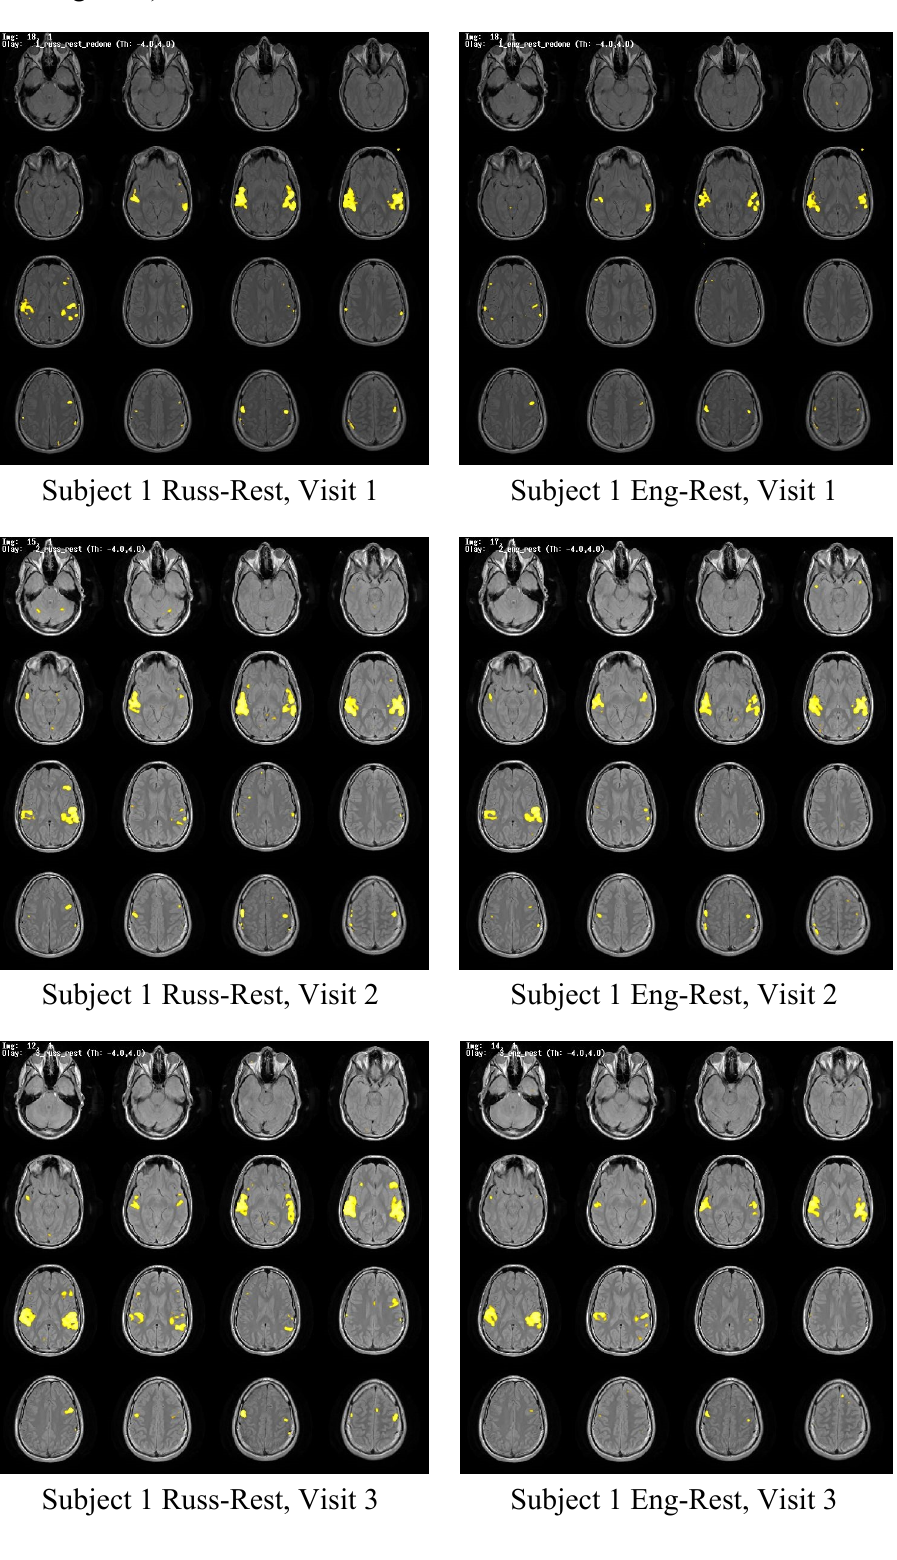
Figure 1. Functional activation t-maps (thresholded at t > 4), superimposed onto proton-density anatomical images, subjects 1 through 5, for three visits in two conditions (Russ-Rest,